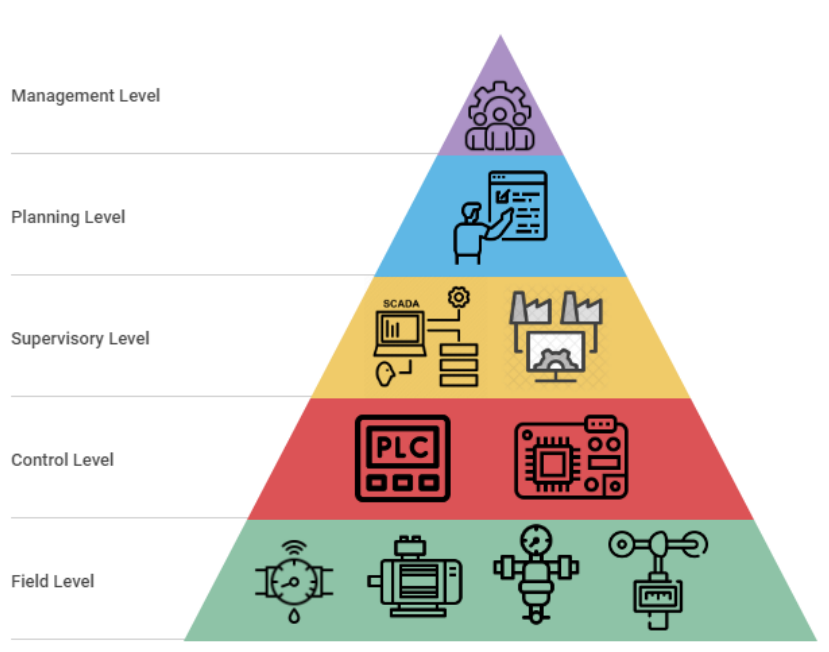
Figure 2. Automation pyramid. Source: